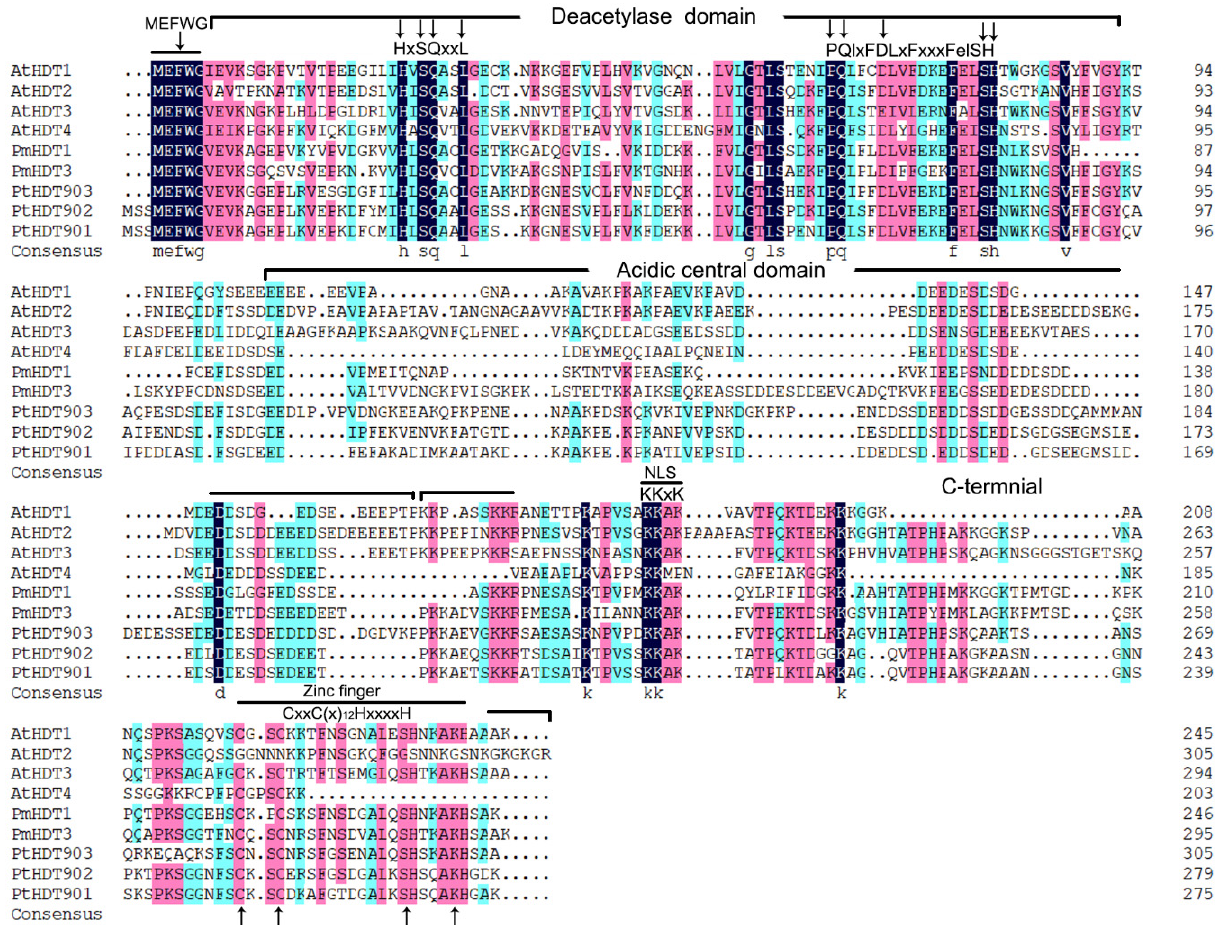
Figure 4. Sequences alignment of HD2 family proteins in Arabidopsis, Populus trichocarpa and mei. Five domains, MEFWG motif, deacetylase domain, acidic central domain, NLS site -KKxK-, and zinc finger domain were marked in these sequences.